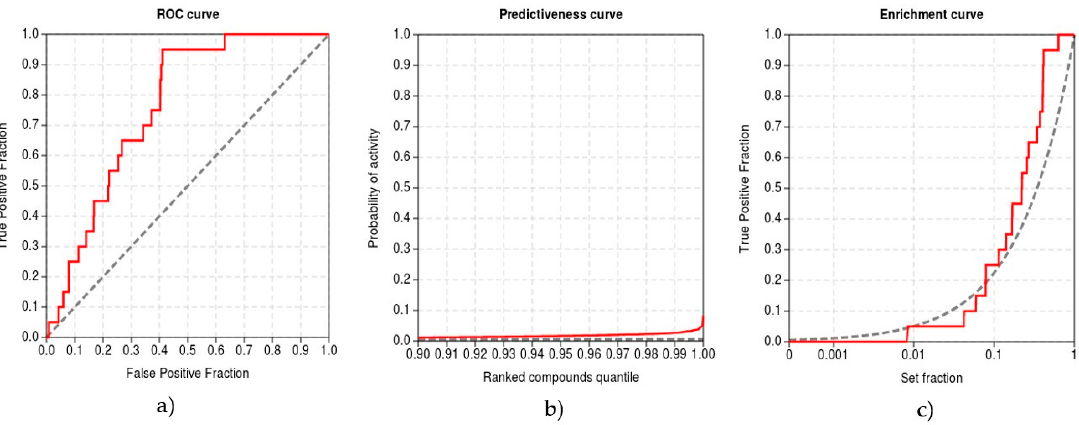
Figure 5. Validation of the inverse molecular docking protocol of curcumin against all human proteins from the Protein Data Bank: ( a ) the receiver operating characteristics (ROC) curve; ( b ) the predictiveness curve; and ( c ) the enrichment